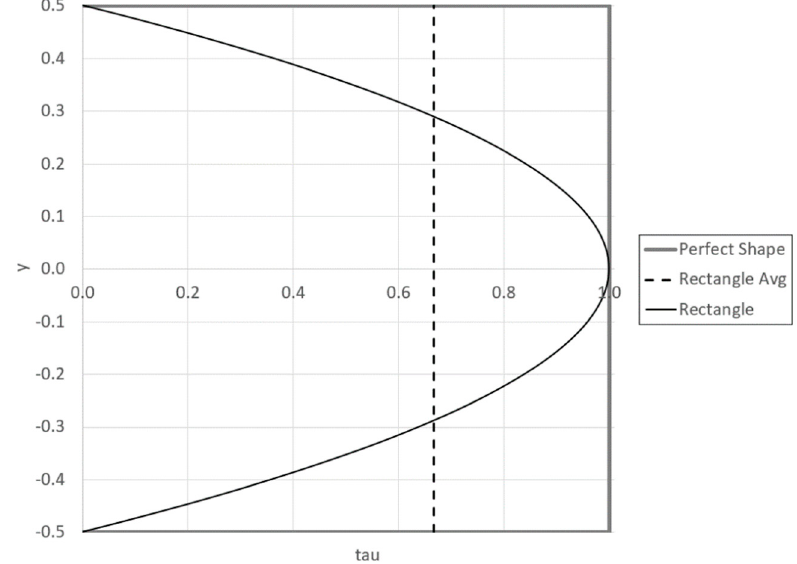
Figure 7. Constant transverse shear stress distribution vs. distribution for a rectangular beam.